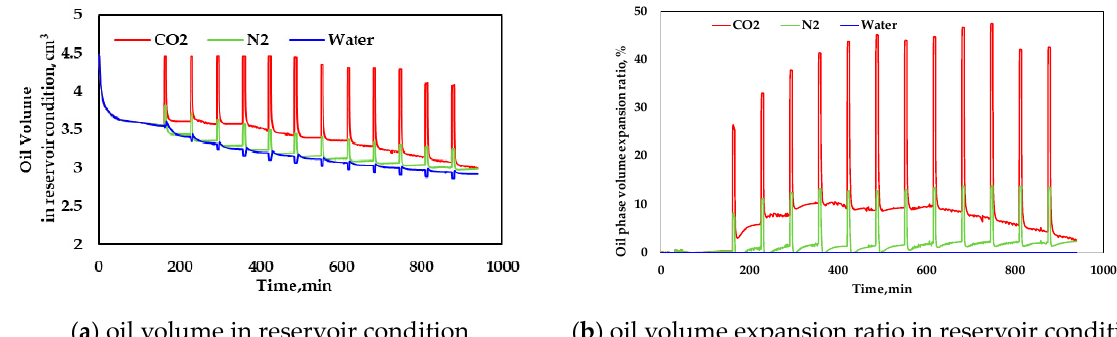
Figure 17. Oil volume in reservoir conditions comparison in Case-4.